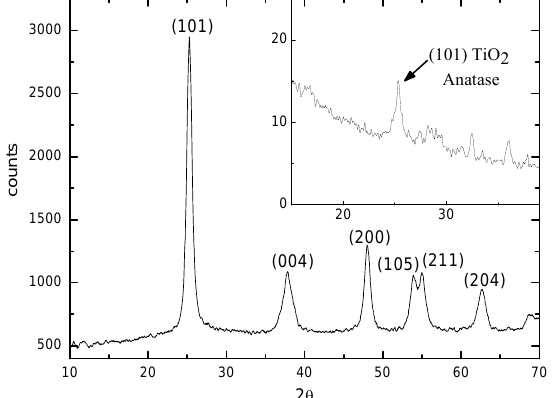
Figure 4 . XRD spectra of the TiO MAPLE-deposited thin film